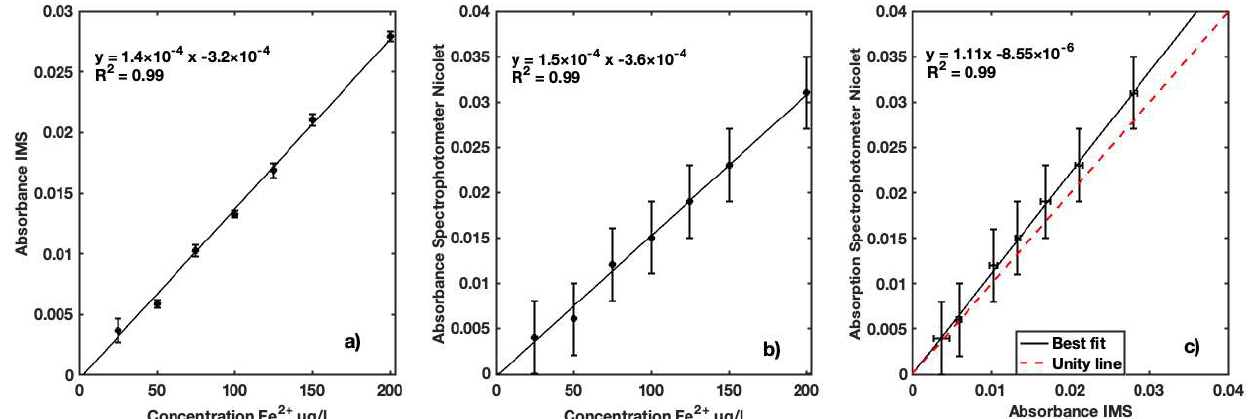
Figure 12. ( a ) Calibration curve for absorption coefficients of Fe 2+ concentrations in distilled water ranging between 25 and 200 ug Fe 2+ /L using IMS; ( b ) calibration curve for absorption coefficients of Fe 2+ concentrations in distilled water for same concentration range presented using Nicolet Evolution 300 spectrophotometer; ( c ) best fit of absorption coefficients measured by both devices to determine their performance.